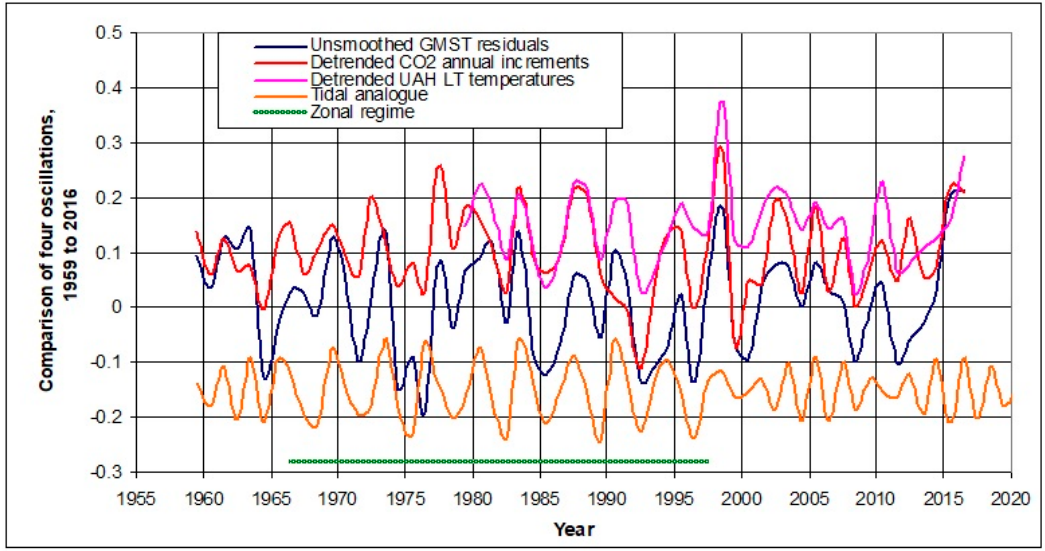
Figure 8. The scaled temporal variation from 1979 to 2016 of the unsmoothed GMST residual anomalies, detrended UAH lower tropospheric temperatures, and detrended CO 2 annual increments and tidal analog. The latter three curves are vertically offset for clarity.